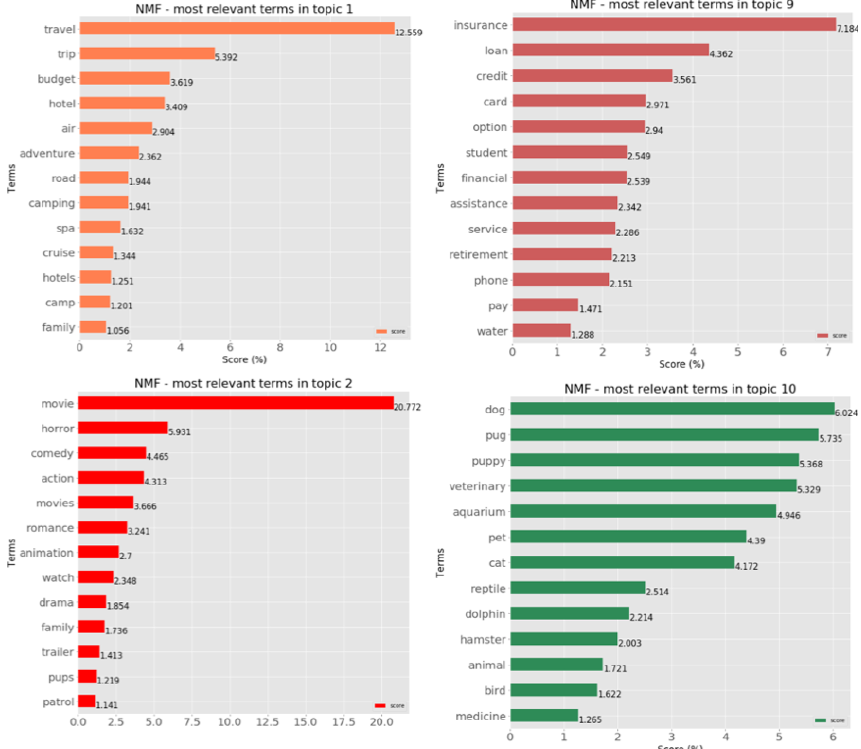
Figure 2. Example topics generated by